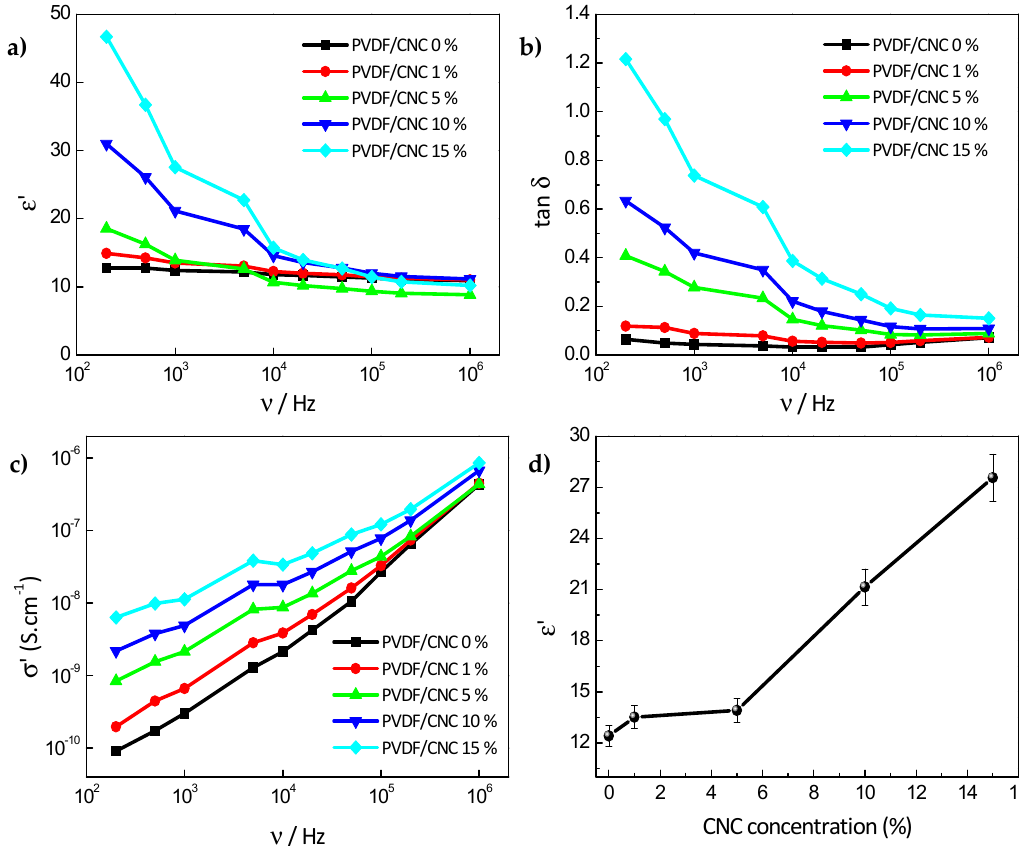
Figure 6. Dielectric spectroscopy results. ( a ) Frequency dependence of the real part of the permittivity, ( b ) tangent loss, ( c ) real part of the dielectric constant and dielectric loss tangent at 1 KHz as a function of CNC concentration, and ( d ) concentration dependence of the real part of the permittivity for PVDF / CNC nanocomposites.